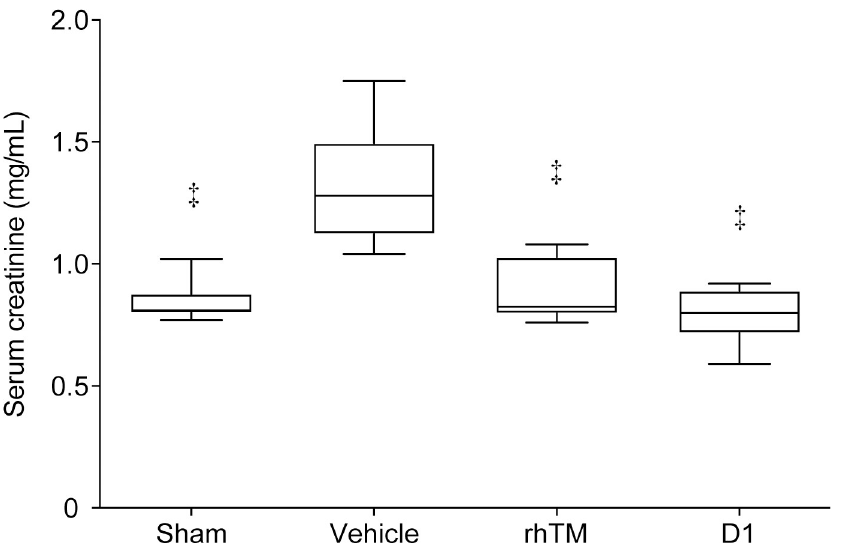
Fig 4. Serum creatinine level in rats after CLP procedure. Administration of rhTM and D1 improved serum creatinine levels. n = 6 per group. ‡ P � 0.001 vs. vehicle.